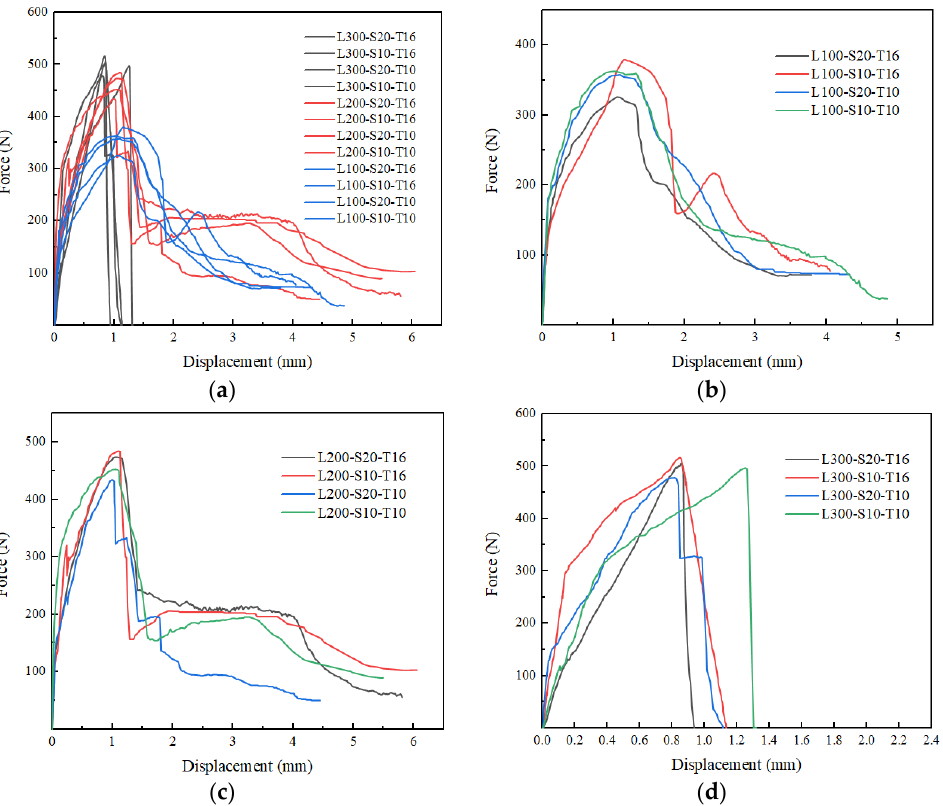
Figure 6. Force versus displacement curves: ( a ) all series, ( b ) 100 mm, ( c ) 200 mm, and ( d ) 300 mm development length.